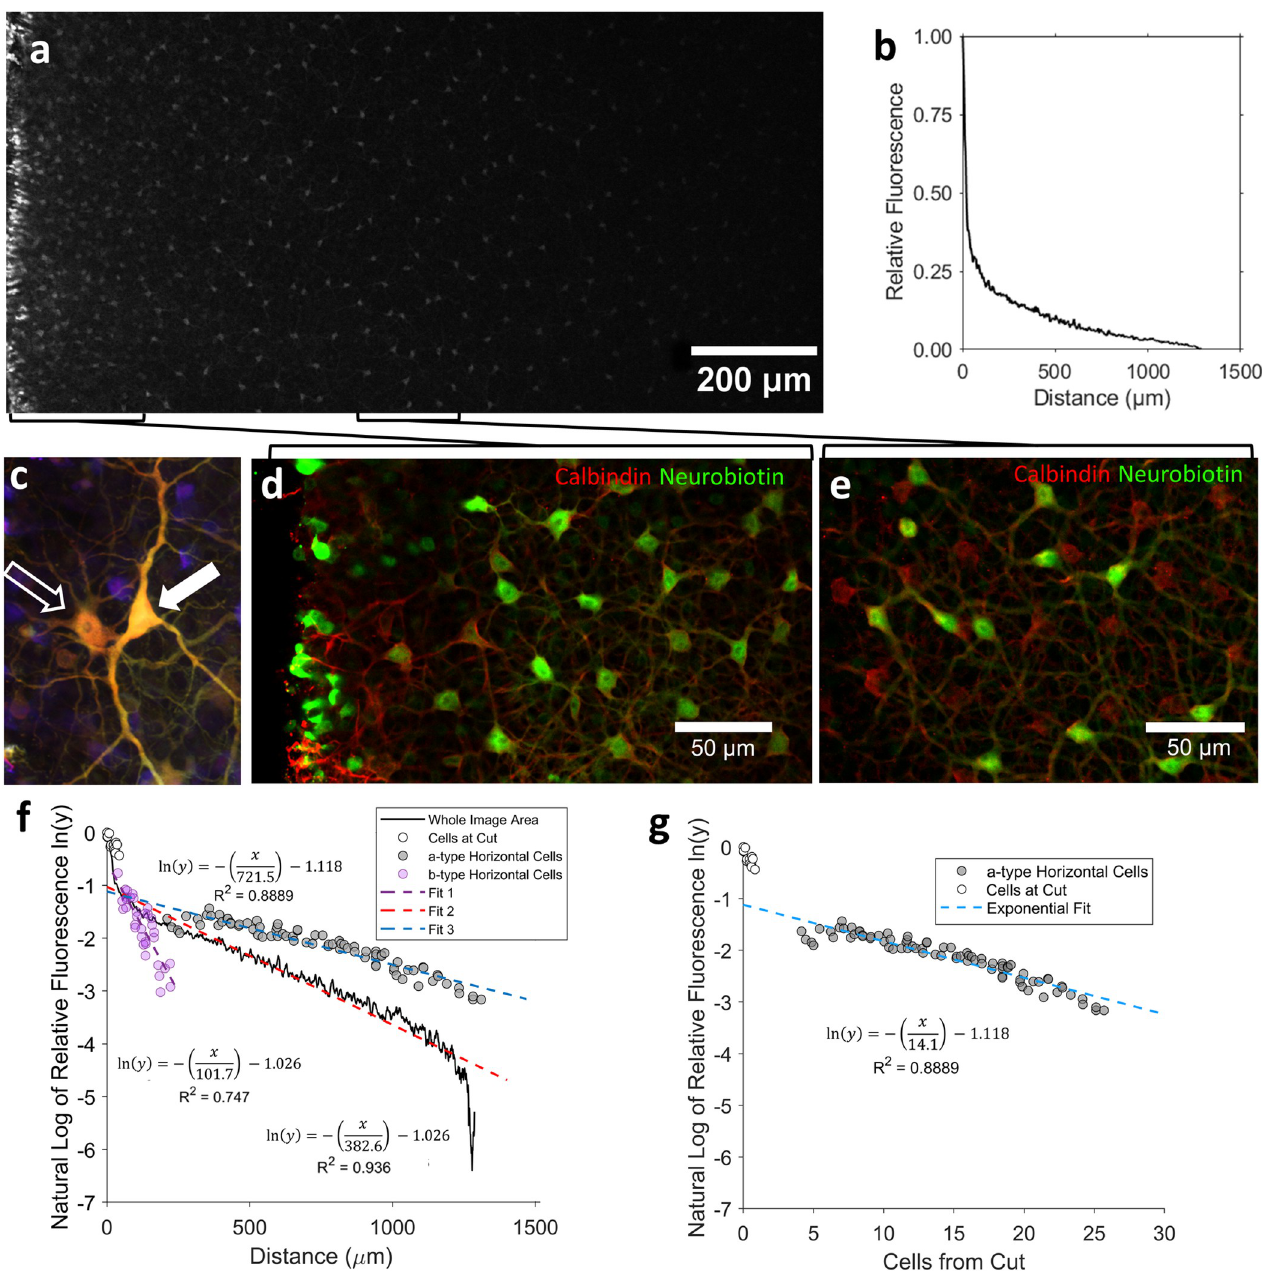
Fig 4. (a) Example image taken in outer portion of the inner nuclear layer of a Guinea pig retina cut-loaded with Neurobiotin TM . (b) The fluorescent intensity of the whole image measured along the horizontal axis extended away from the cut. (c) Close up of morphologically distinct horizontal cell subtypes: axon- bearing (‘B-type’, open arrow) and axon-less (‘A-type’, closed arrow) HCs. Image created from cut-loaded retina using the temporal colour-code function in Fiji for optical slices spanning the inner nuclear layer (see methods). (d) Cut-loaded aHCs and bHCs located adjacent to the cut, loaded with Neurobiotin TM (green) and co-labelled with Calbindin (red). (e) Cut-loaded aHCs located 500 μ m from the cut, loaded with Neurobiotin TM (green) and co-labelled with Calbindin (red). (f) Semi-log plot of fluorescent intensity data from (b) (dashed red line) and fluorescent intensity of individual aHCs (grey markers, dashed blue line) and bHCs (purple markers, dashed purple line)), each fitted with an exponential decay function, Eq (1). (g) Fluorescent intensity of individual aHCs adjusted for the mean soma-soma cell distance.